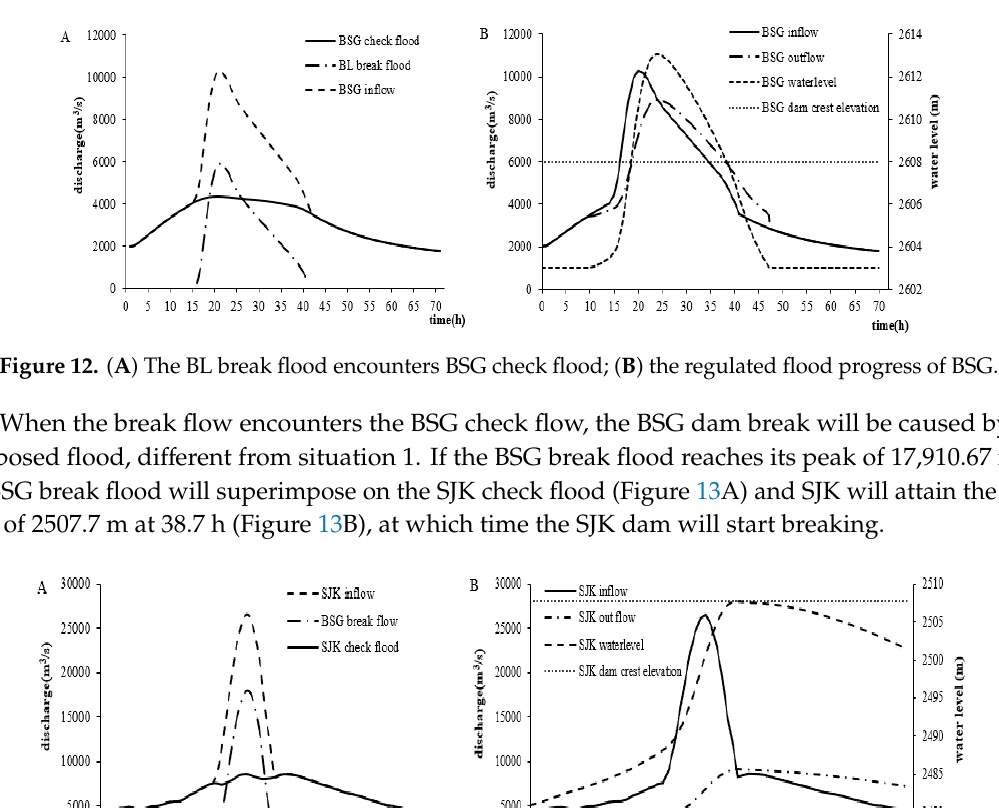
Figure 13. ( A ) The BSG break flood encounters SJK check flood; ( B ) the regulated flood progress of